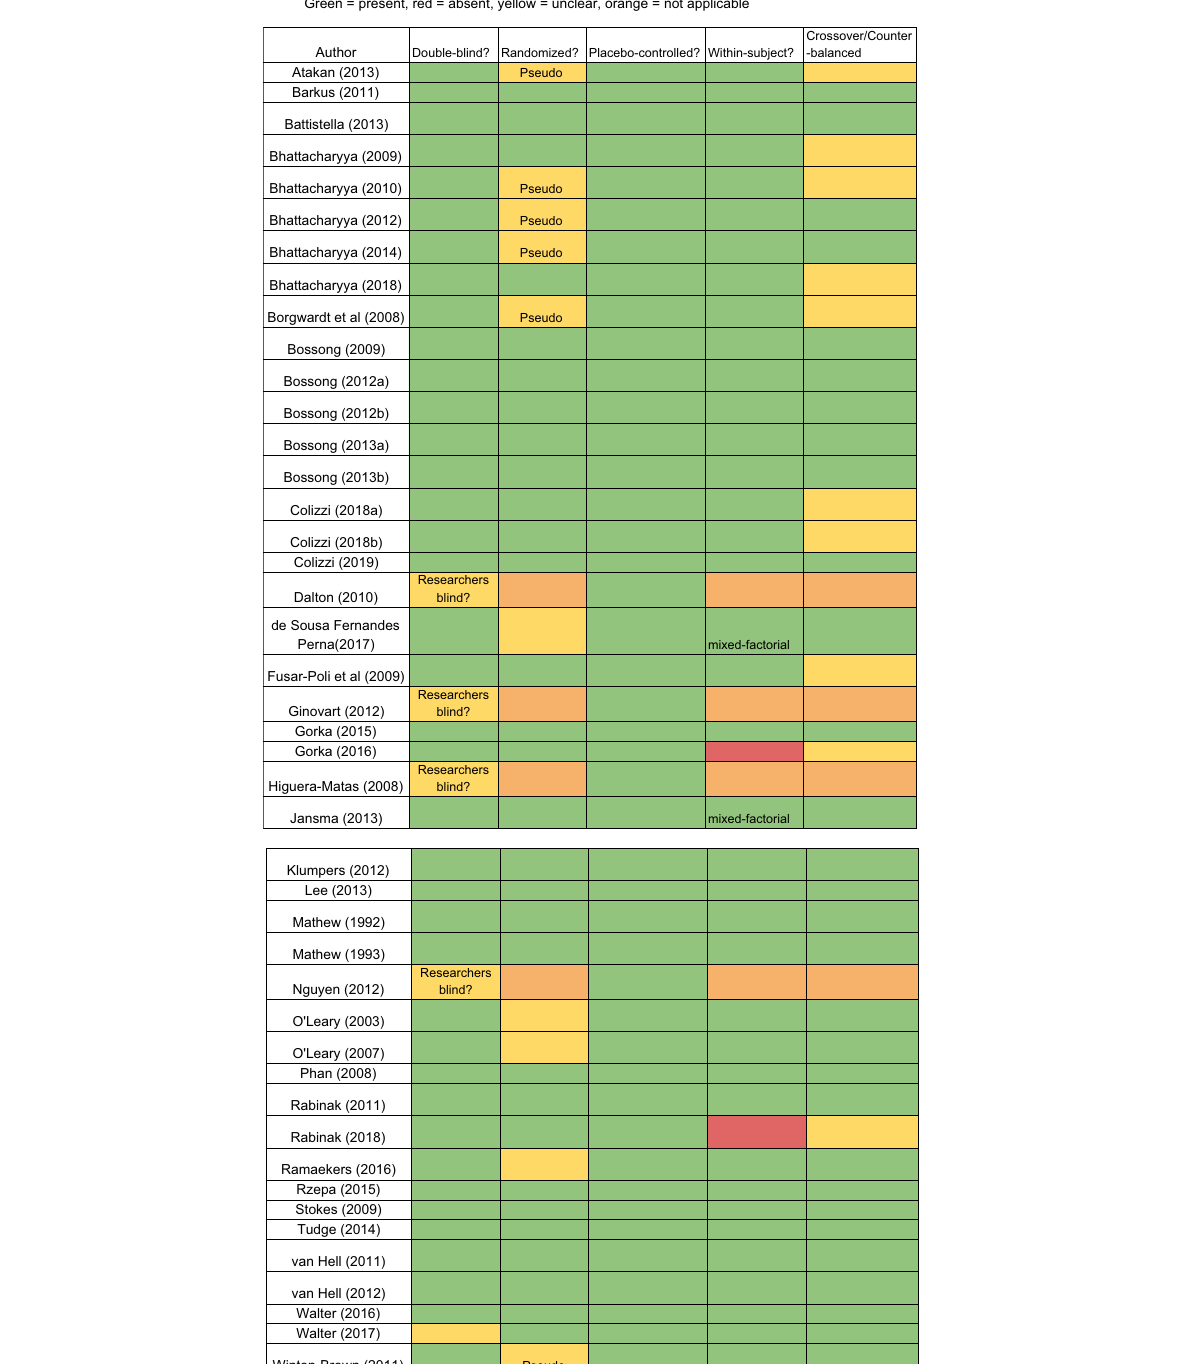
Fig. 4 Risk of bias. Assesses likelihood of bias in each paper examining for double-blind, randomized, placebo-controlled, within-subject, and crossover/counter-balanced. Green = present, red = absent, yellow = unclear, orange = not